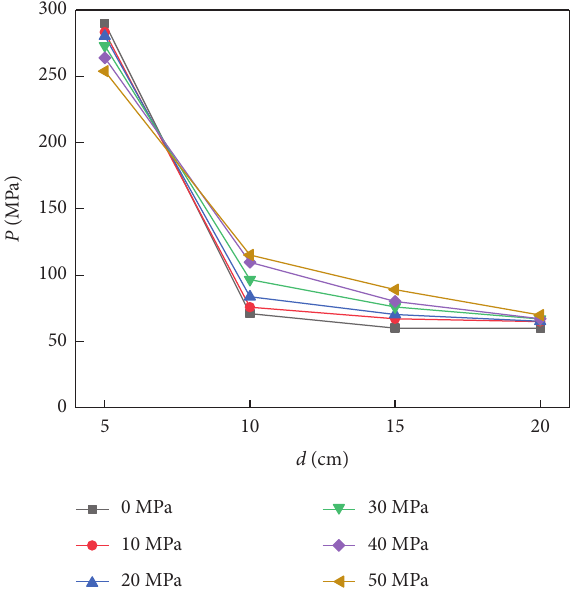
Figure 6: Change curve of stress peak value with distance.